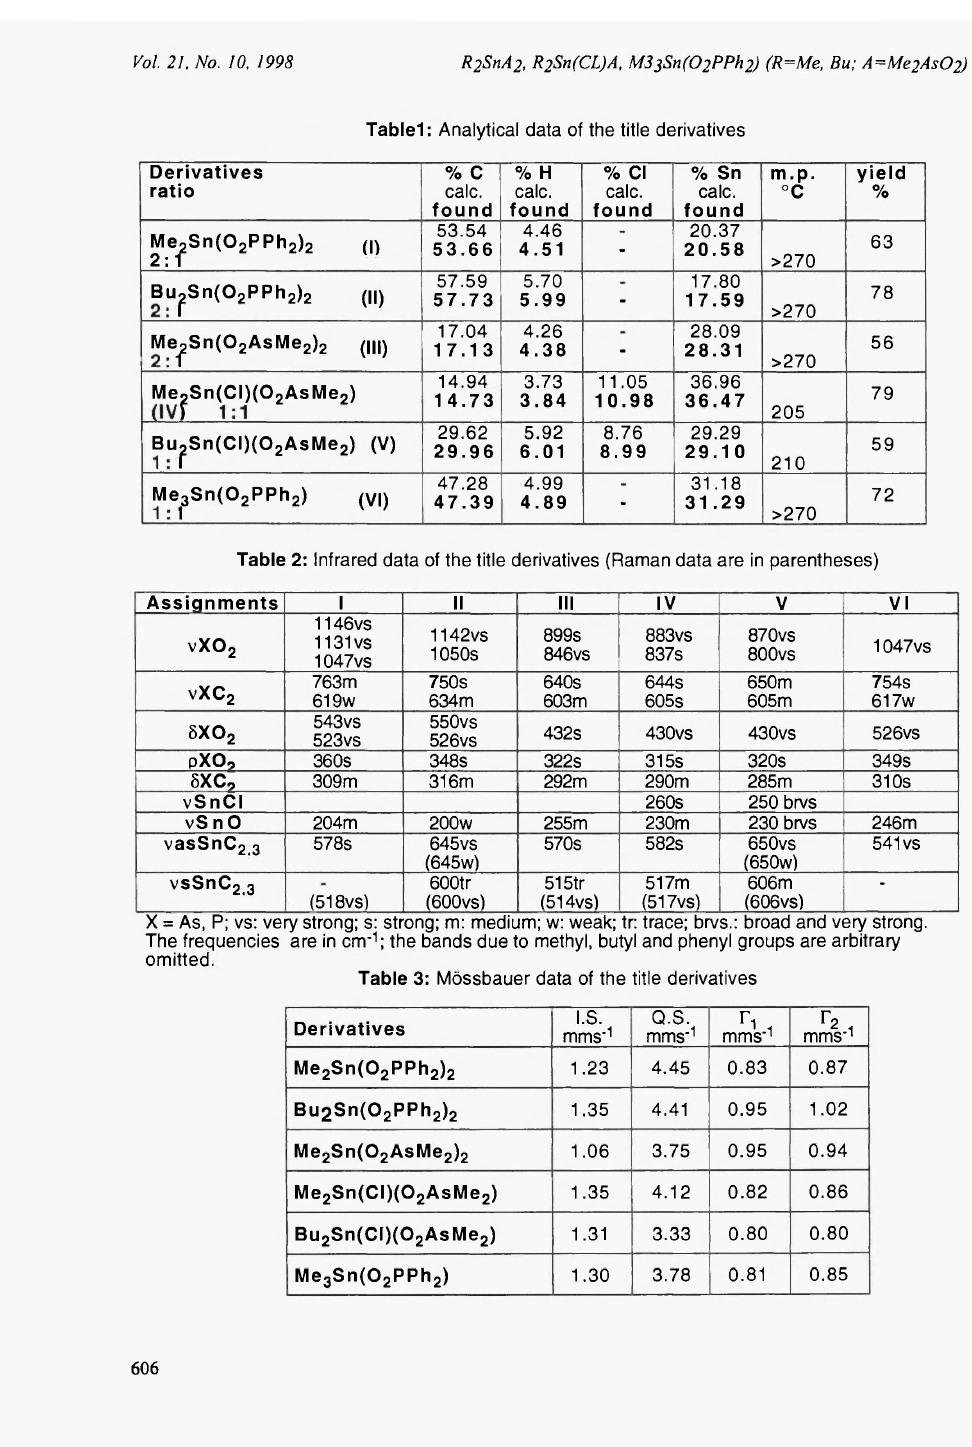
Table!: Analytical data of the title derivatives